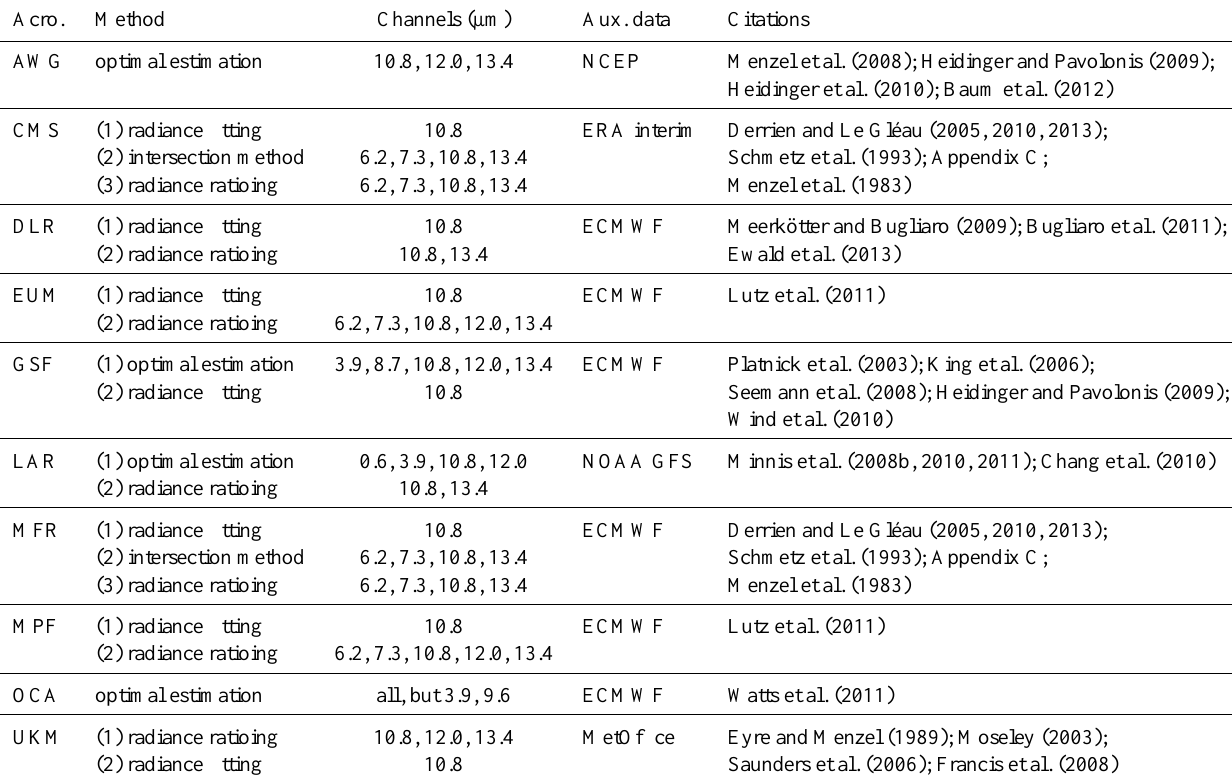
Table 4. SEVIRI cloud top height retrieval methods.